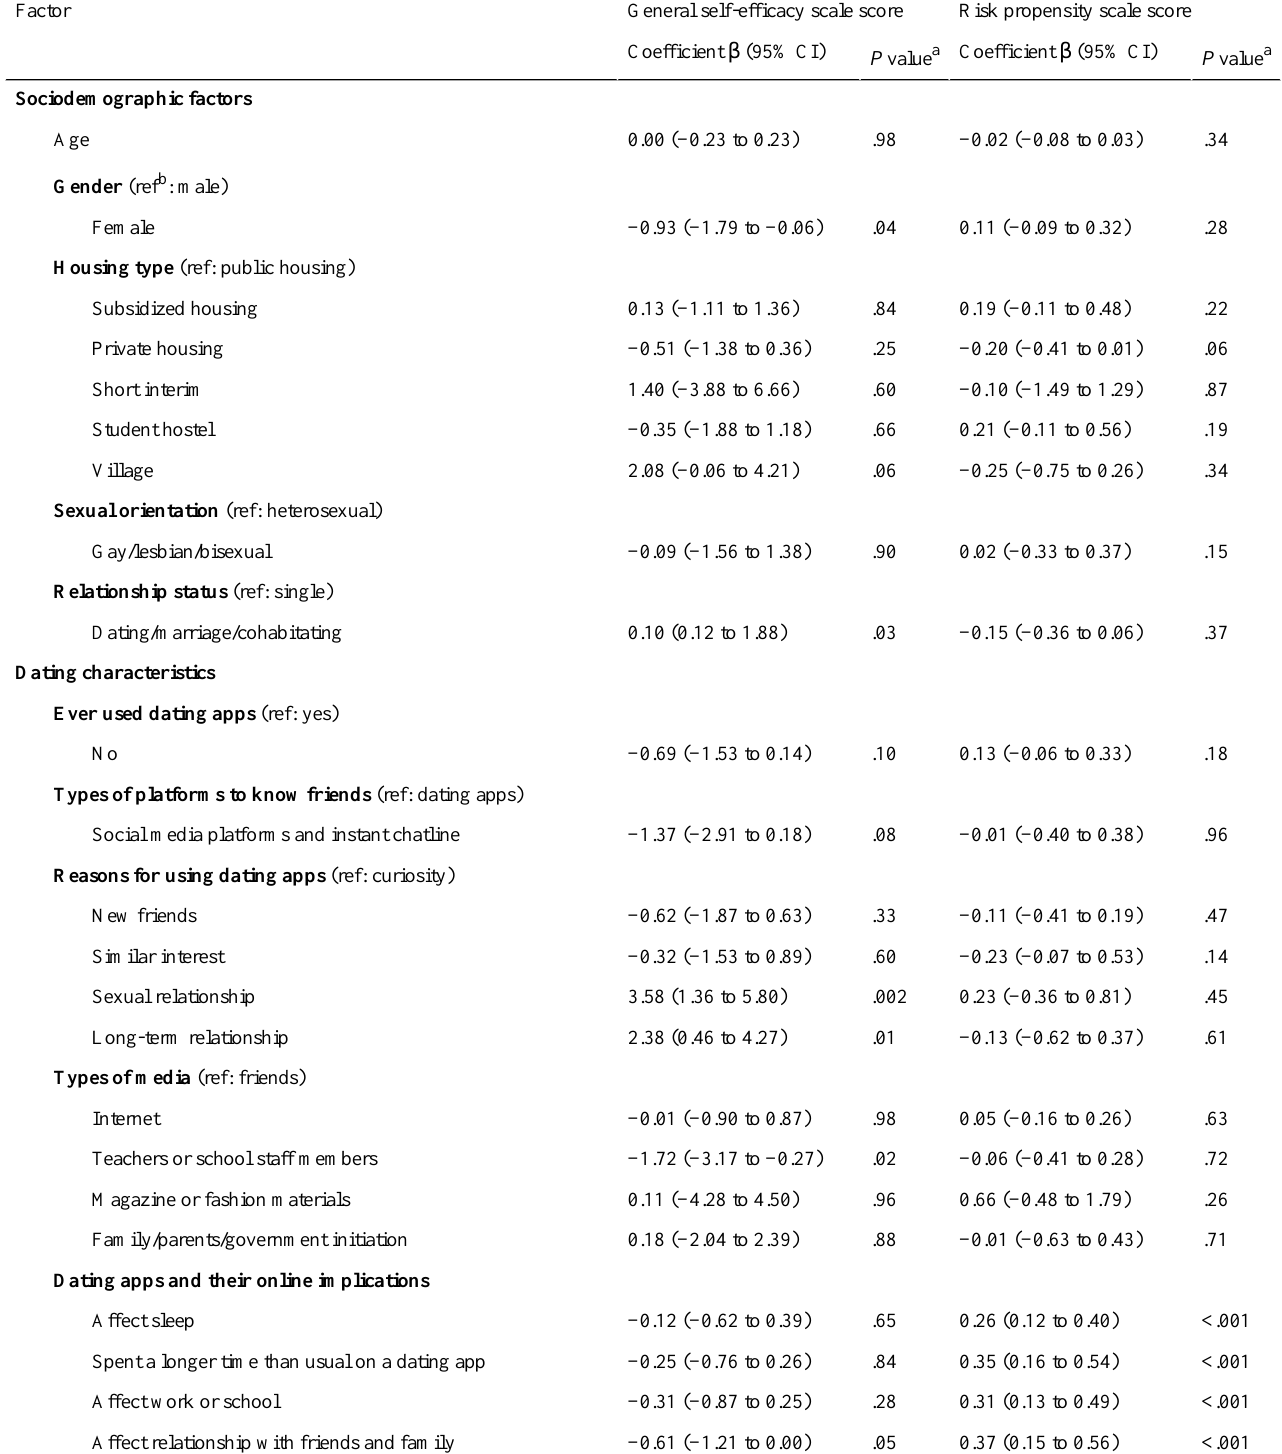
Table 5. Factors affecting the general self-efficacy scale and risk propensity scale scores using a univariate regression model.